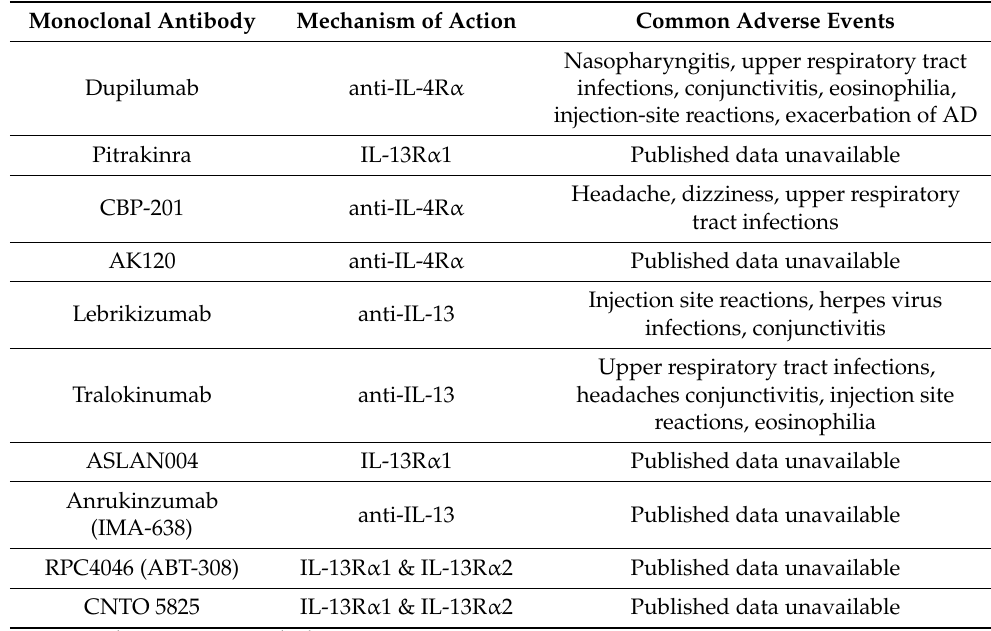
Table 1. Summary of IL-4 and IL-13 inhibitory monoclonal antibodies, their respective mechanism of action and their most common adverse events